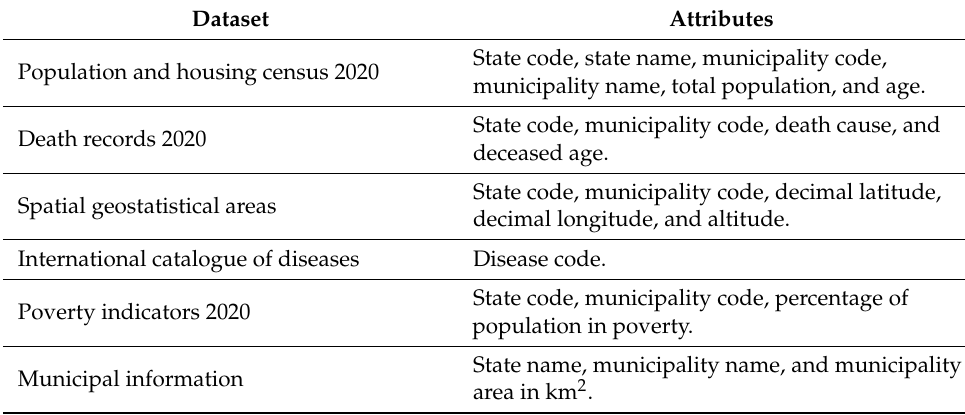
Table 2. Attributes selected for each dataset.